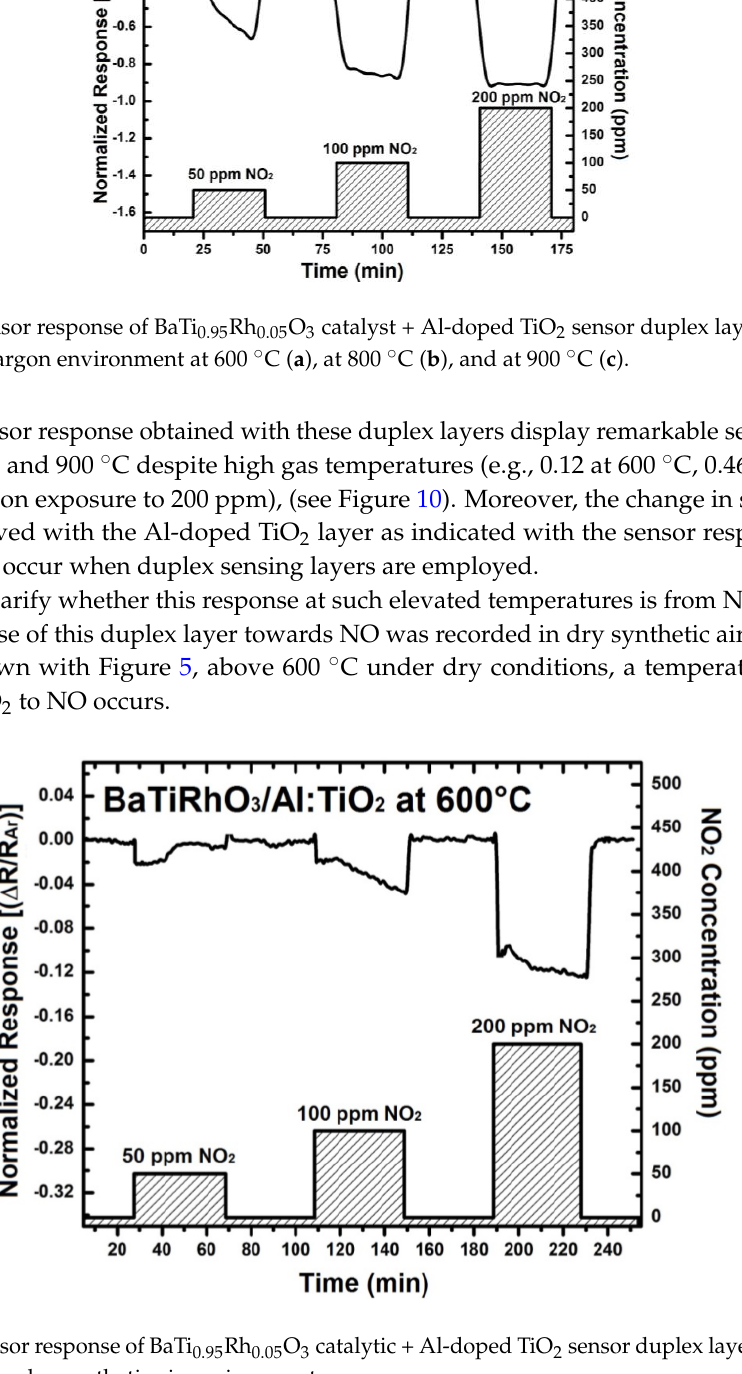
Figure 11. Sensor response of BaTi 0.95 Rh 0.05 O 3 catalytic + Al-doped TiO 2 sensor duplex layers at 600 °C toward NO in a dry synthetic air environment.